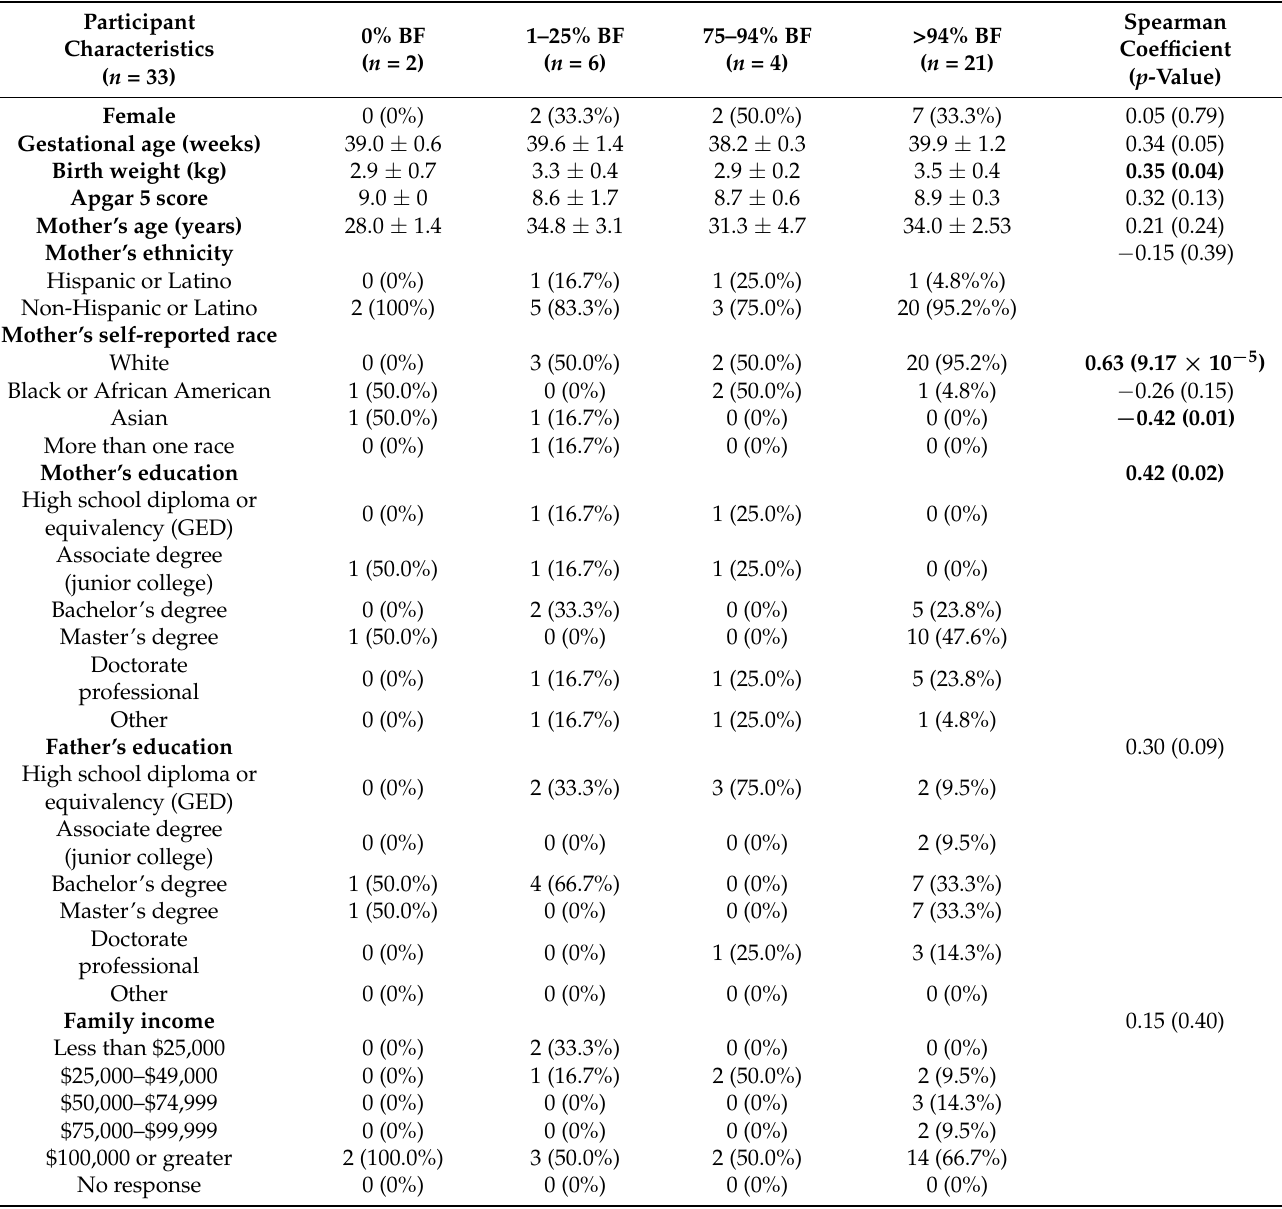
Abbreviations: breastfeeding, BF. Bold text in Spearman coefficient column indicates significant associations with p <